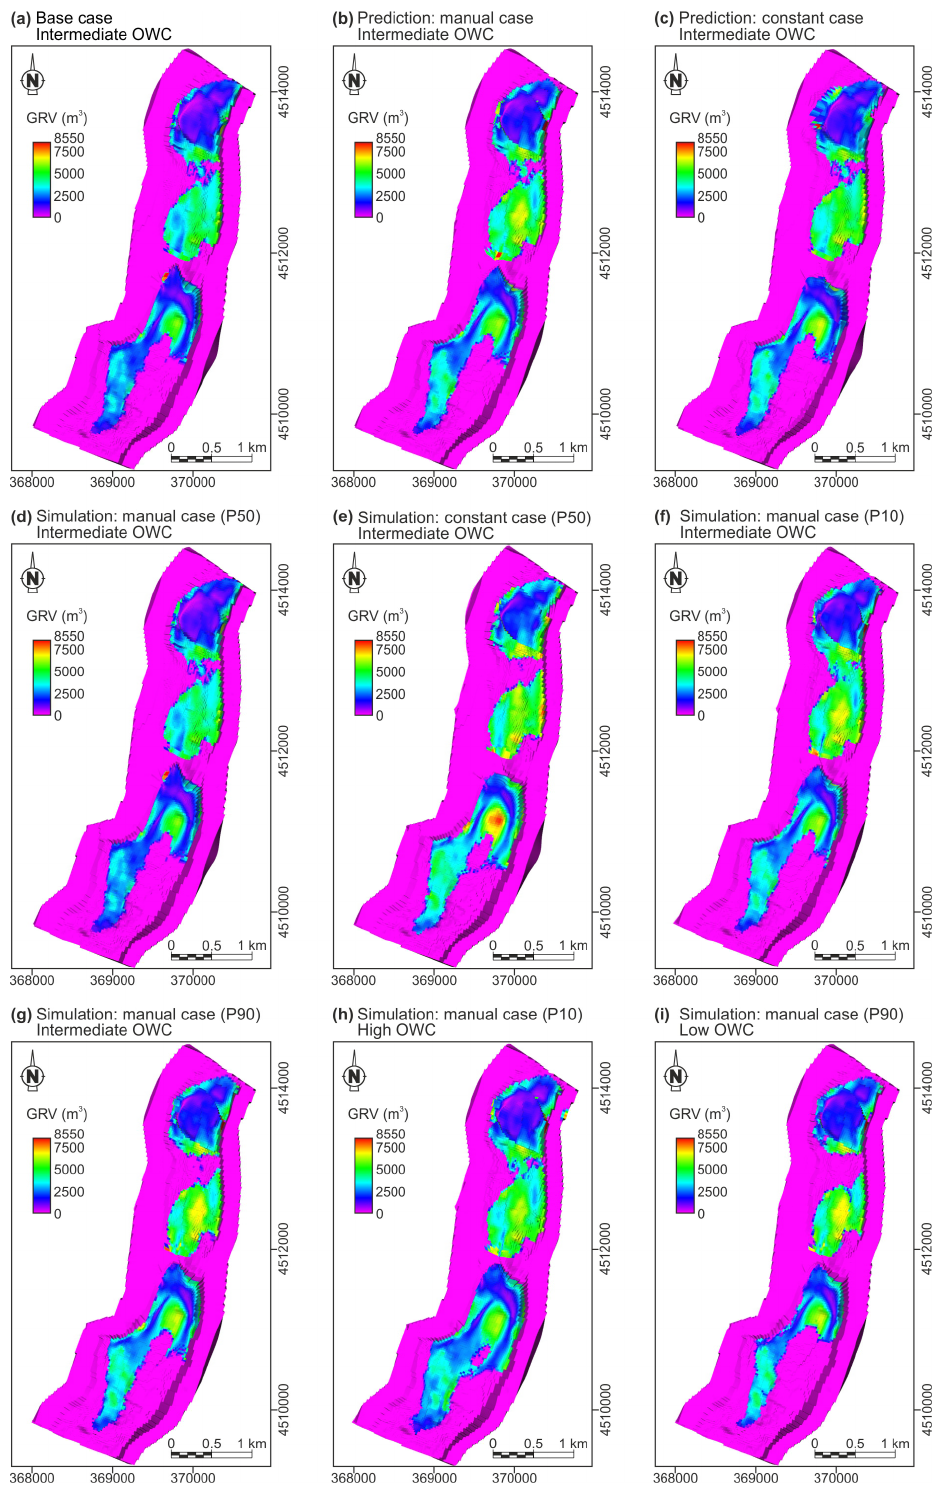
Figure 12. Top view of the 3-D grids with the oil gross volume distribution for (a) the base case model; the prediction method for (b) the manual and (c) the constant uncertainty case; the P50 realization of (d) the manual and (e) the constant uncertainty cases; (f) the P10 (possible volume) and (g) the P90 (proven volume) for the manual uncertainty case, in the intermediate OWC depth scenario. (h) The P10 in the high OWC scenario, and (i) the P90 in the low OWC scenario for the manual uncertainty